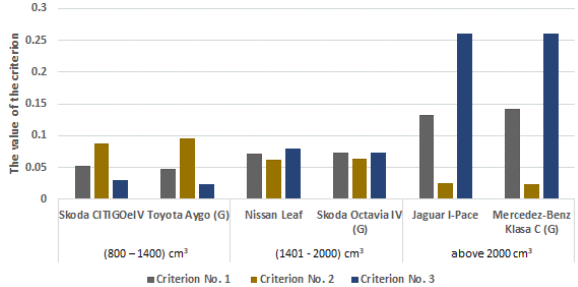
Fig. 1. Summary of the criteria for the selection of cars for testing in terms of engine displacement. G – gasoline, D – diesel